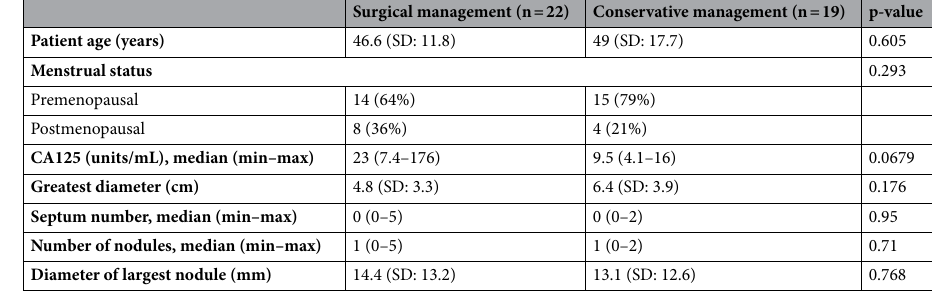
Table 5. IOTA indeterminate adnexal mass characteristics. Of the 41 IOTA indeterminate masses 22 were eventually surgically managed (9 had some form of follow up imaging first). The remaining 19 were followed conservatively with imaging and or exams. At 2 years of follow up, they either resolved, demonstrated satisfactory stability or were further characterized by MRI as benign. Clinical and imaging characteristics of these two groups were compared and there were no statistically significant